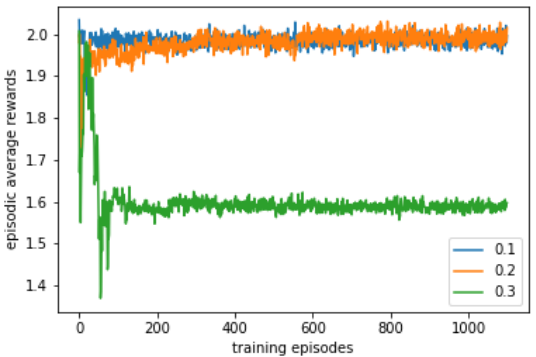
Figure 5. Episodic average rewards while training with different clip